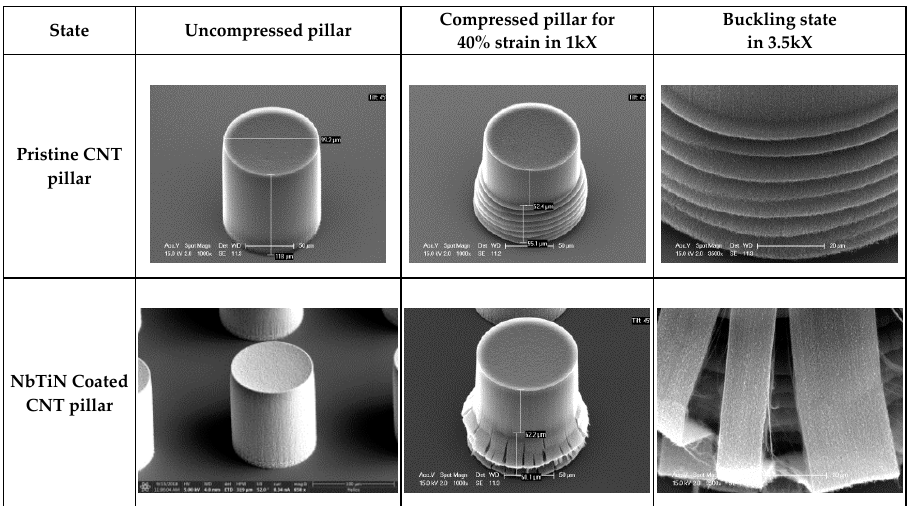
Figure 8. SEM images of compressed coated and pristine CNT pillars with 100 µm diameters after 40 µm compression.